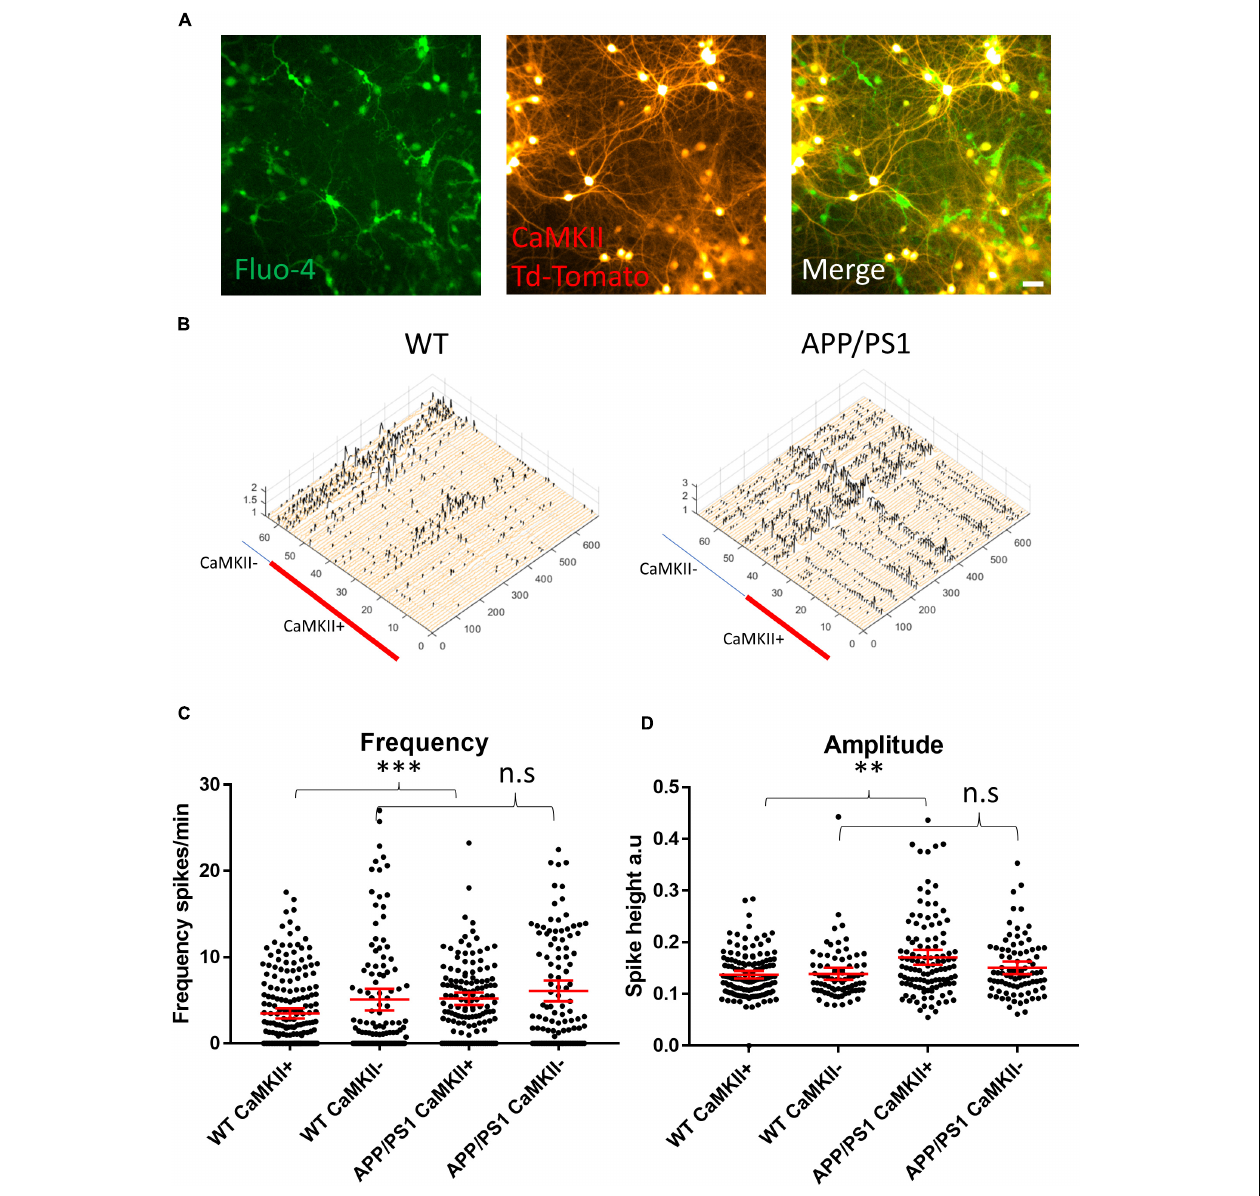
FIGURE 2 | Increased amplitude and frequency of spontaneous calcium transients in CaMKII positive excitatory neurons. (A) Micrograph provides an example of an image of Fluo-4 (green) and CaMKII TdTomato (red) neurons in culture. (B) Representative calcium traces from WT and APP/PS1 FOVs, black spikes are recognized by the Peakcaller algorithm. X -axis shows ROI number, Y -axis shows amplitude and Z -axis shows time point. The red line shows which ROIs belonged to CaMKII positive neurons in the representative FOVs. (C) Graph showing increase in spike frequency (spikes per minute) of APP/PS1 CaMKII positive compared to WT CaMKII positive neurons (APP/PS1 mean = 5.176, CI = 4.456–5.896, n = 133 compared to WT mean = 3.479, CI = 2.9–4.057, n = 205, p = 0.0001). In contrast, spike frequency of CaMKII negative APP/PS1 neurons did not significantly differ from WT CaMKII negative neurons (APP/PS1 mean = 6.094, CI = 4.898–7.291, n = 108 compared to WT mean = 5.083, CI = 3.837–6.328, n = 114, p = 0.124). (D) Amplitude of transients is increased specifically in APP/PS1 compared to WT CaMKII positive excitatory neurons (APP/PS1 mean = 0.171, CI 0.1566–0.1856, n = 115, compared to WT mean = 0.1375, CI = 0.1304–0.1446, n = 138, p = 0.0024). In contrast, the amplitude of transients in CaMKII negative neurons did not differ between APP/PS1 and WT neurons (APP/PS1 mean = 0.1505, CI = 0.1385–0.1625, n = 85, compared to WT mean = 0.1391, CI = 0.1275–0.1506, n = 78, p = 0.302); N = 3. Kruskal–Wallis test with Dunn’s correction for multiple comparisons. n.s = not significant, ∗ p < 0.05, ∗∗ p < 0.01, ∗∗∗ p < 0.001; scale bar: 50 µ